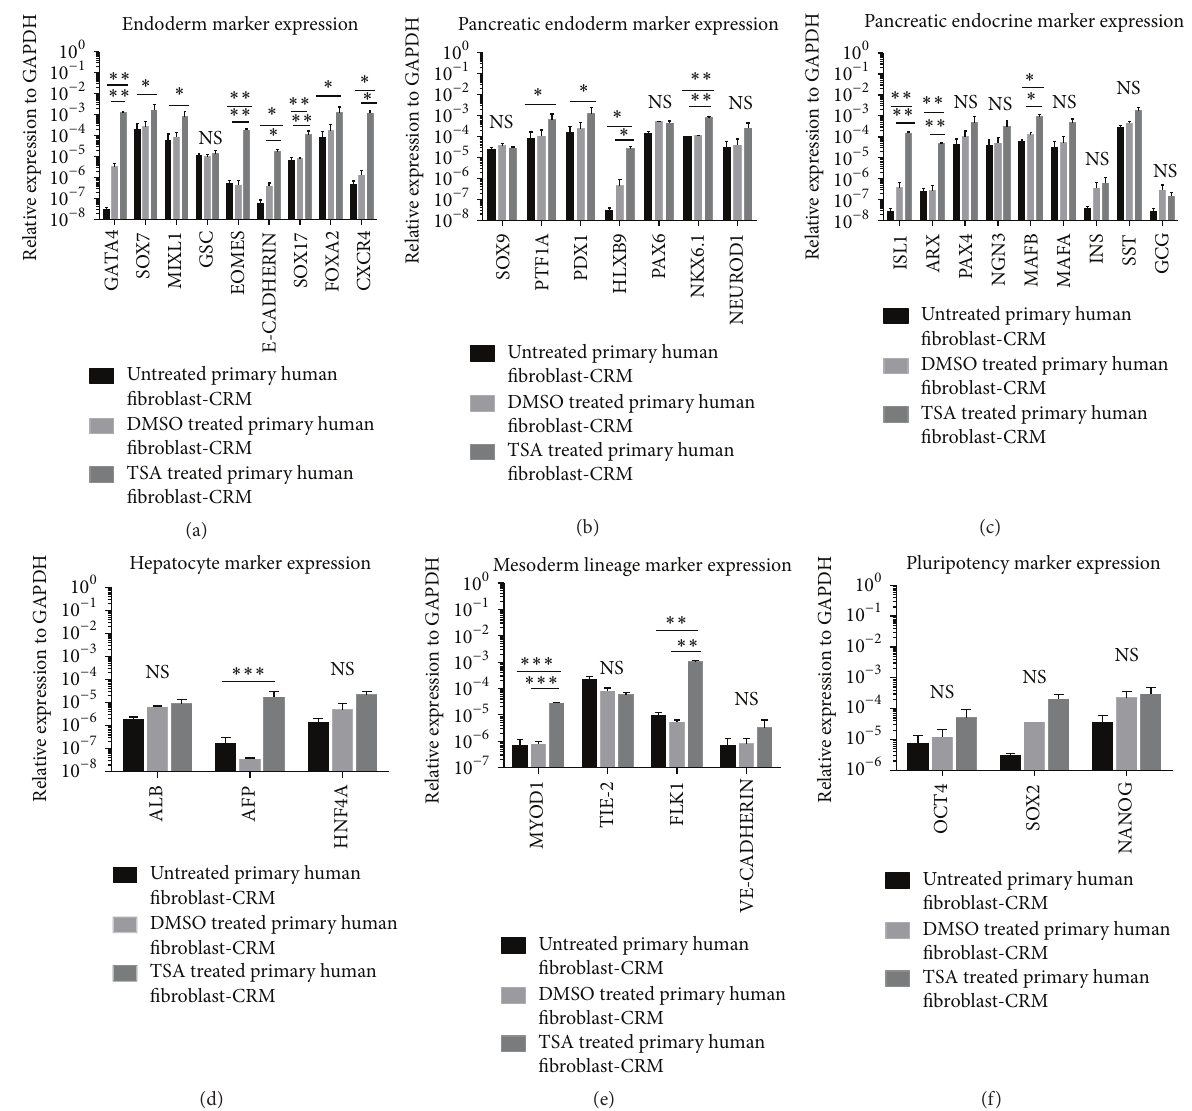
Figure 1: Trichostatin A (TSA) treatment of primary adult fibroblasts induces transient definitive endoderm and pancreatic endoderm markers.(a)qRT-PCRanalysisdemonstratedinductionofendodermalgenes( GATA4,SOX7,MIXL1,EOMES,E-CADHERIN,SOX17,FOXA2, and CXCR4 but not GSC ) in TSA-CRM treated primary human fibroblast. (b) qRT-PCR analysis demonstrated induction of pancreatic endoderm genes ( PTF1A, PDX1, HLXB9, and NKX6.1 but not SOX9, PAX6, and NEUROD1 ) in TSA-CRM treated primary human fibroblast. (c) qRT-PCR analysis demonstrated induction of pancreatic endocrine genes ( ISL1, ARX, and MAFB but not PAX4, NGN3, MAFA, INS, SST, and GCG )inTSA-CRMtreatedprimaryhumanfibroblast.(d)qRT-PCRanalysisdemonstratedthathepatocytegenes( ALB and HNF4A )were not induced except for AFP . (e) qRT-PCR analysis demonstrated induction of mesoderm lineage genes ( MYOD1 and FLK1 but not TIE-2 and VE-CADHERIN ) in TSA-CRM treated primary human fibroblast. (f) qRT-PCR analysis demonstrated no induction of pluripotency genes ( OCT4, SOX2, and NANOG ) expression in TSA-CRM treated primary human fibroblast. Black bar, CRM treated primary human fibroblast cells; light grey bar, DMSO-CRM primary human fibroblast treated cells; dark grey bar, 100 𝜇 M TSA-CRM treated primary human fibroblast cells. Gene expression is shown relative to the housekeeping gene GAPDH . Data represent the mean ± SEM (standard error of mean) of three independent experiments. Statistical significance tests were performed between TSA treated versus untreated fibroblast and TSA treated versus DMSO treated fibroblast. ∗ 𝑝 < 0.05 , ∗∗ 𝑝 < 0.01 , and ∗∗∗ 𝑝 < 0.001 by unpaired 2-tailed Student’s 𝑡 -test. NS, not significant.